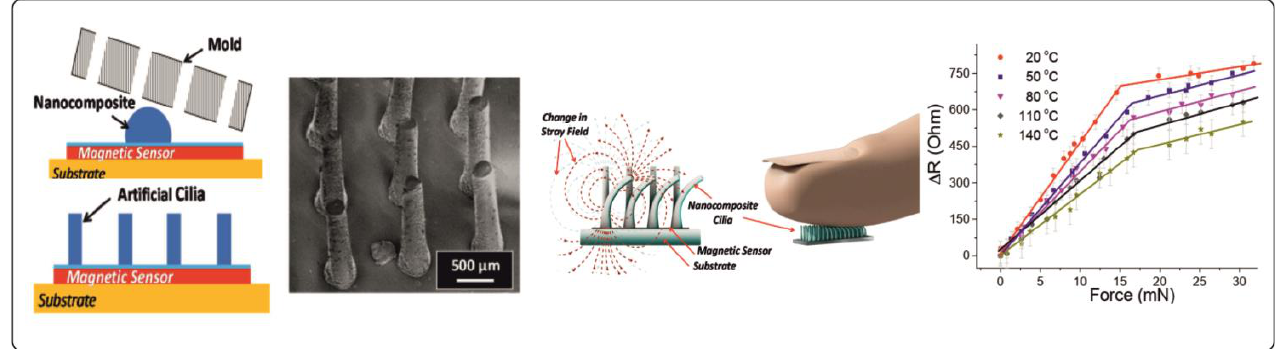
Figure 16. An illustration of the fabrication process of the magnetic cilia tactile sensor, and an SEM image of the sensor. The response of the tactile sensor is initiated by applying vertical pressure in the temperature range from 20 to 140 °C. Reproduced from [168]. CC BY 4.0.